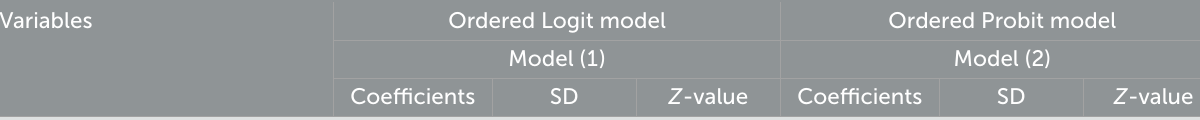
TABLE 6 The regression results of the ordinal dependent variable model of the influencing factors of the GMP inspection results of pharmaceutical